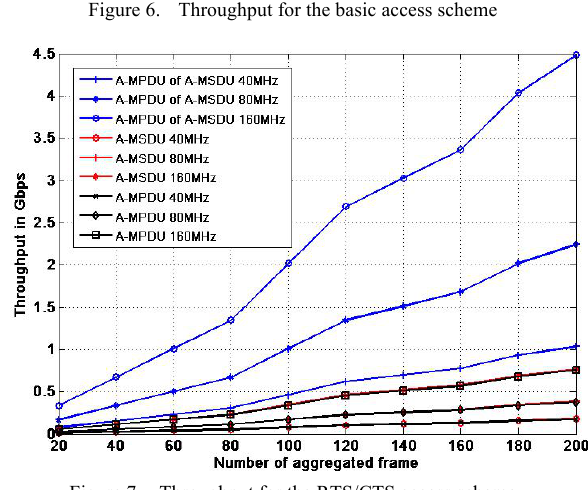
Figure 7. Throughput for the RTS/CTS access scheme